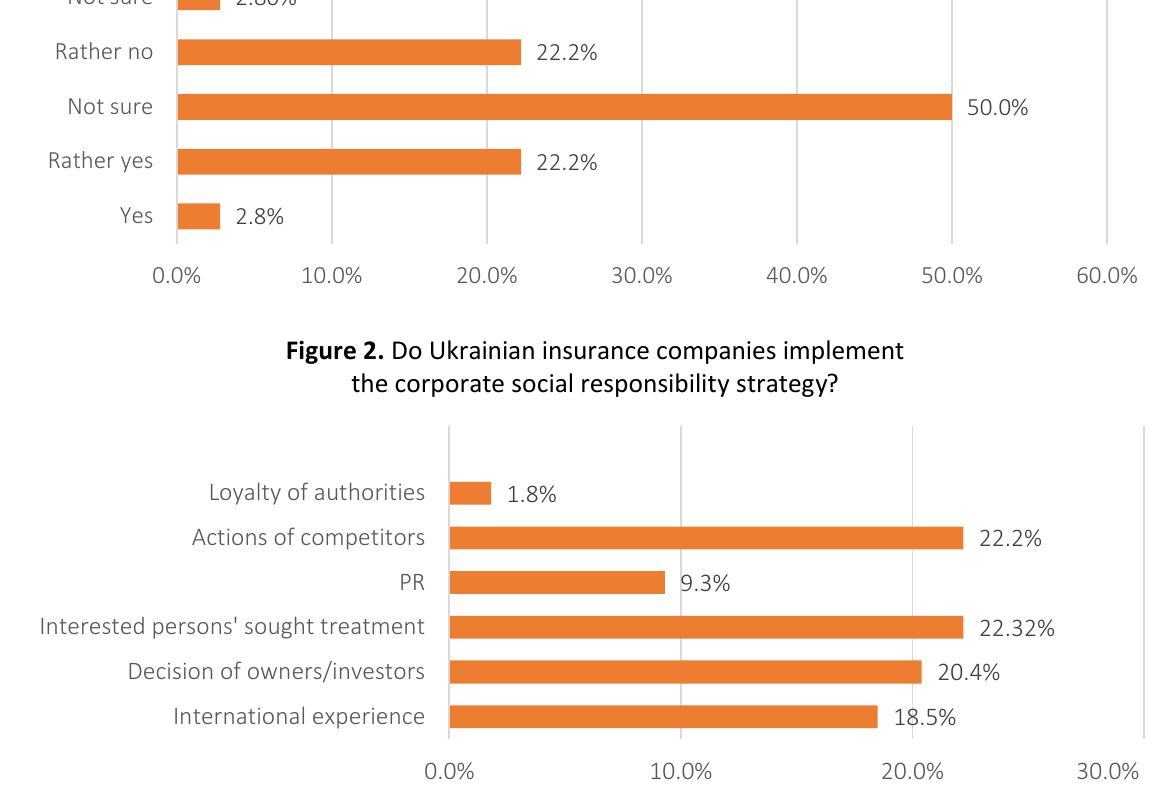
Figure 3. Basic motives that prompt insurance